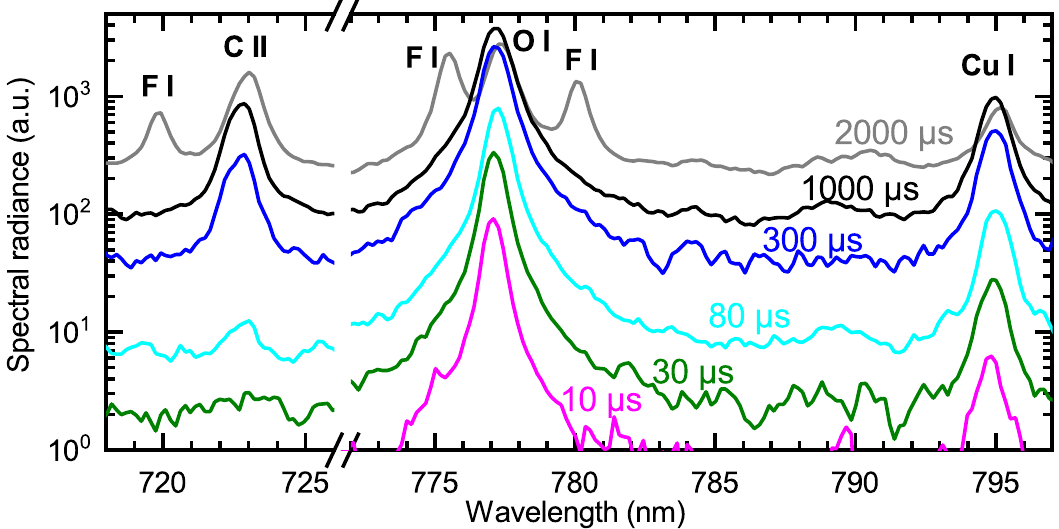
Figure 9. Selection of spectra acquired at different instants of time before the current